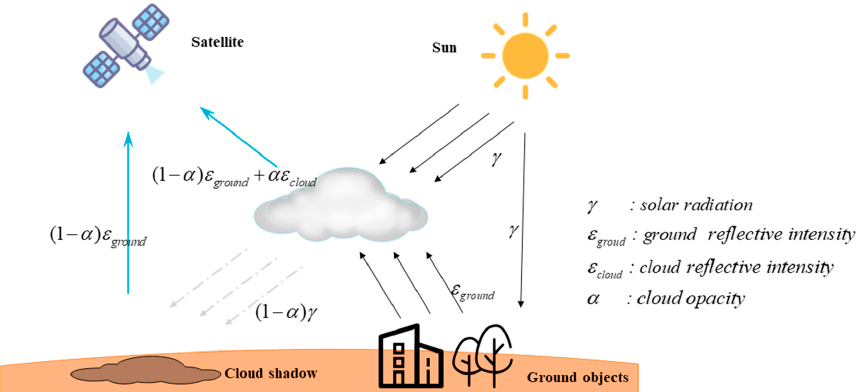
Figure 1. A schematic diagram of the remote sensing imaging process. The reflected energy received by sensors is a linear superposition of the reflected energy from the cloud’s top and the reflected energy from the surface for given cloud transparency.